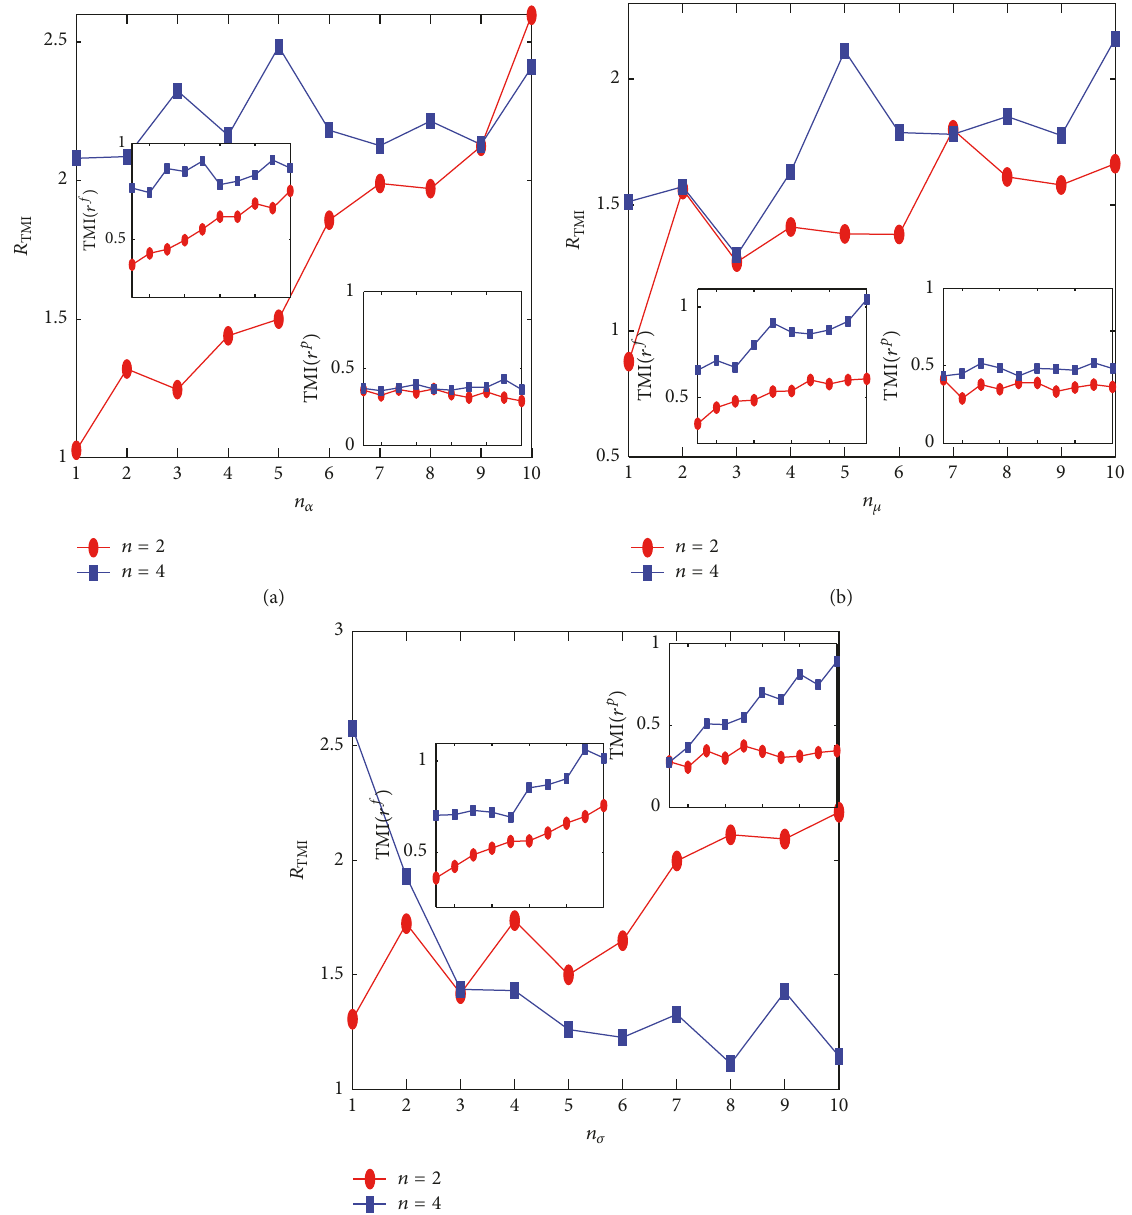
Figure 5: Dependence and relative dependence against changes of different information characteristics of common